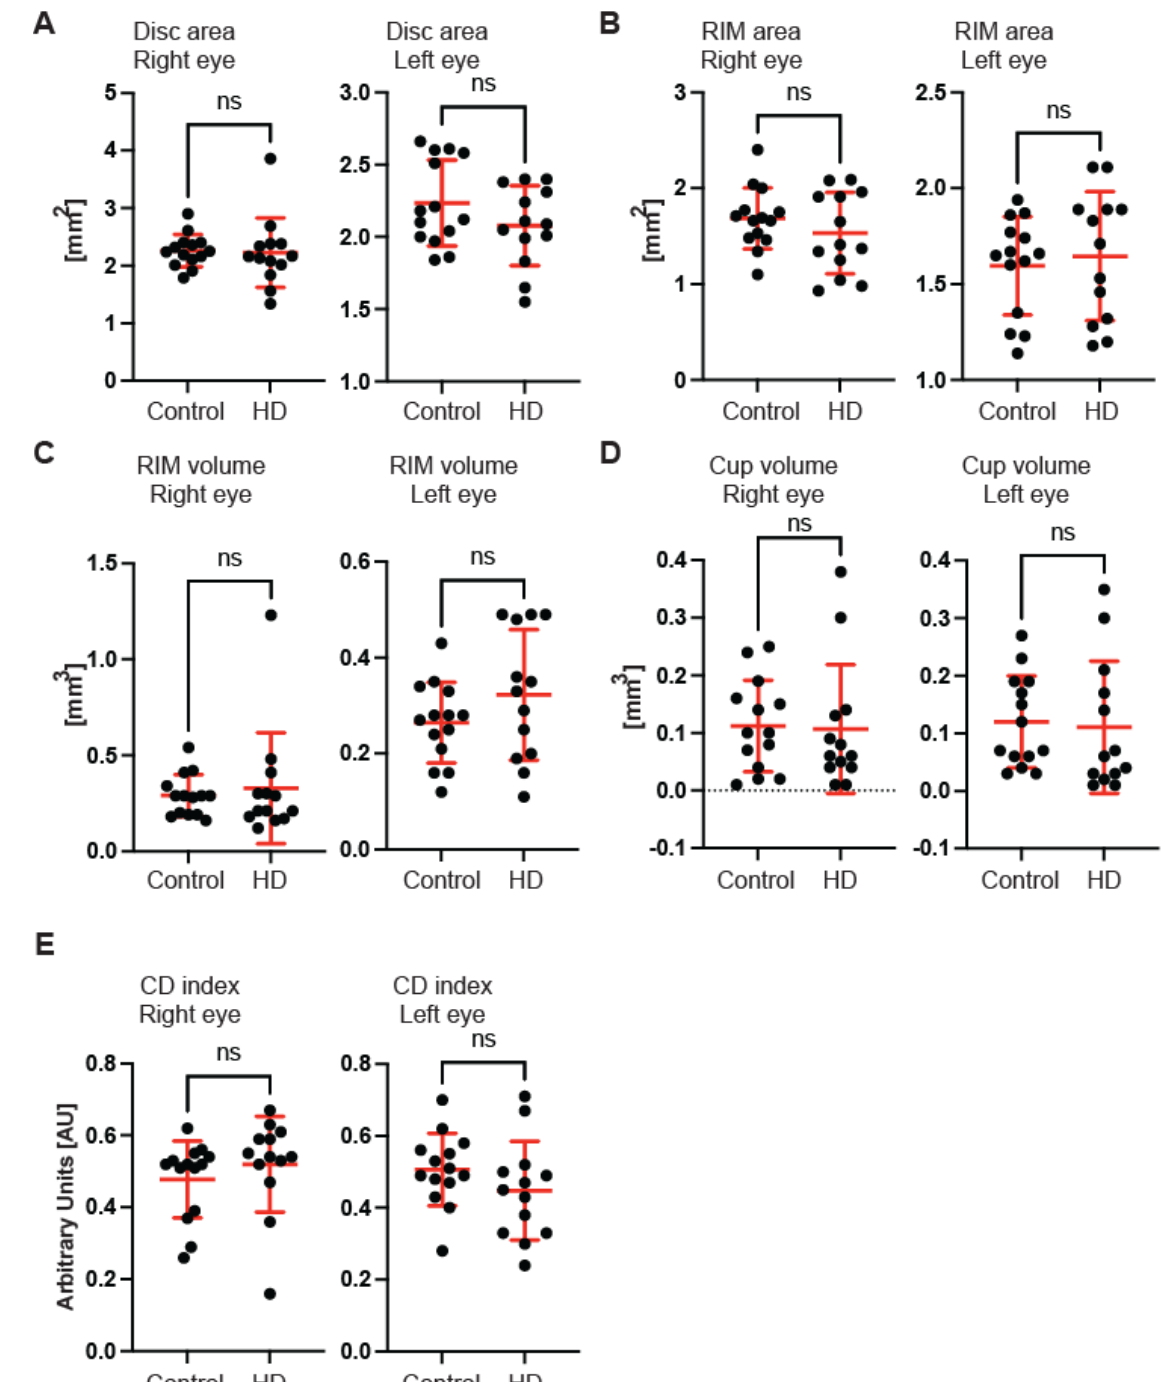
Figure 1. Optical coherence tomography of the retinal nerve fibre layer (RNFL) parameters in HD gene carriers and healthy controls. The following parameters have been assessed in pre-symptomatic HD carriers and age- and sex-matched healthy individuals: ( A ) total RNFL thin- ning, ( B ) the eye symmetry, ( C ) superior RNFL thinning, ( D ) inferior RNFL thinning, ( E ) nasal RNFL thinning and ( F ) temporal RNFL thinning. Error bars are ± SD ( n > 13). One-way ANOVA with Bonferroni post hoc test: * p < 0.05, ** p < 0.01.